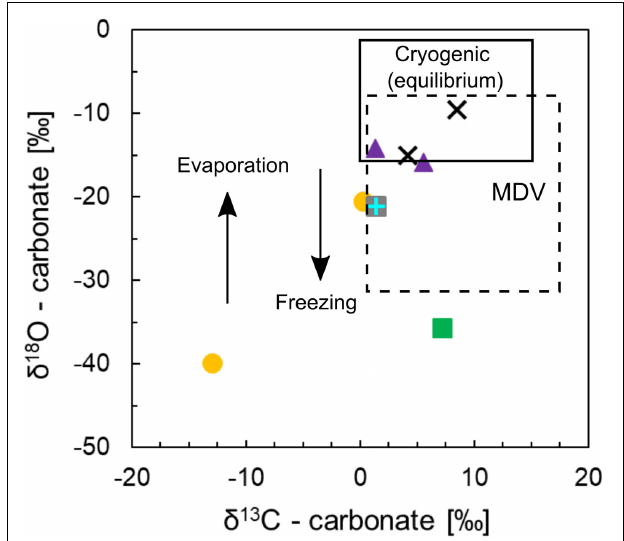
FIGURE 8 | Isotopic composition of total inorganic carbon (HCO 3 + CO 3 ) for Shackleton Glacier soils. δ 13 C and δ 18 O are reported in terms of VPDB. The shapes and colors representing the different sampling locations correlate with the key in Figure 2 . The solid black box represents the composition of cryogenic carbonates formed in equilibrium with the source fluid and atmosphere (slow process). The arrows represent the direction of δ 18 O fractionation with rapid freezing and evaporation/sublimation, and the dashed box represents samples from the McMurdo Dry Valleys (MDV) for comparison (Nakai et al., 1975; Lacelle et al., 2006; Lacelle, 2007; Burgener et al., 2018; Lyons et al.,